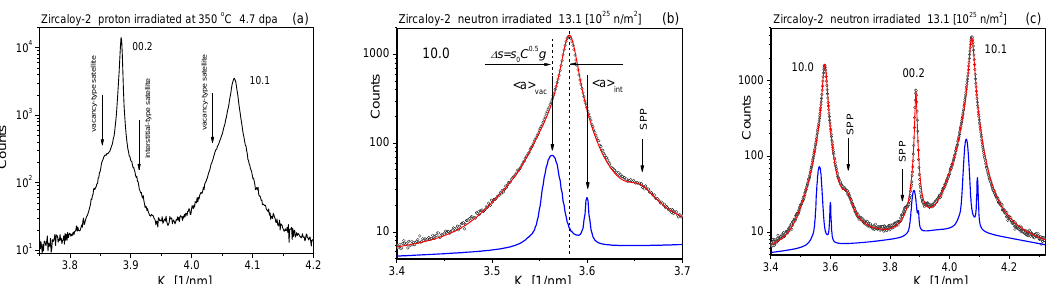
Figure 6. ( a ) Typical satellites in the lower intensity ranges of di ff raction peaks in a proton irradiated Zircaloy-2 specimen. The vertical arrows point to the satellite peaks produced either by vacancy- (on the left side of the peaks) or interstitial-type dislocation loops (on the right side of the 00.2 reflection). The interstitial-type satellite peak is blending in with the broader 10.1 Bragg peak. ( b ) Measured (open circles) and CMWP-calculated (red line) zoomed part of the di ff raction pattern of a Zircaloy-2 cladding material specimen [58] neutron irradiated to 13.1 × 10 25 n / m 2 . The blue line shows the satellite peak related to vacancy- and interstitial-type dislocation loops. ( c ) The same as in ( a ) for the first three Zr peaks. The alloy contains second-phase particles (SPPs) of di ff erent precipitates, as indicated in the ( b ) and ( c ) figures.